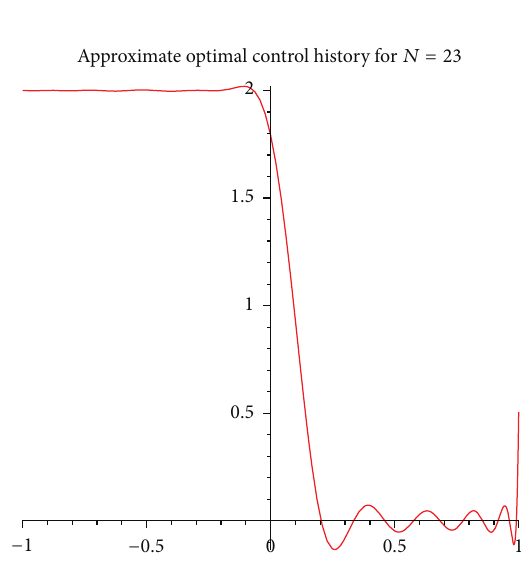
Figure 1: Approximate optimal control history of Example 1 for 𝑁 = 21 .